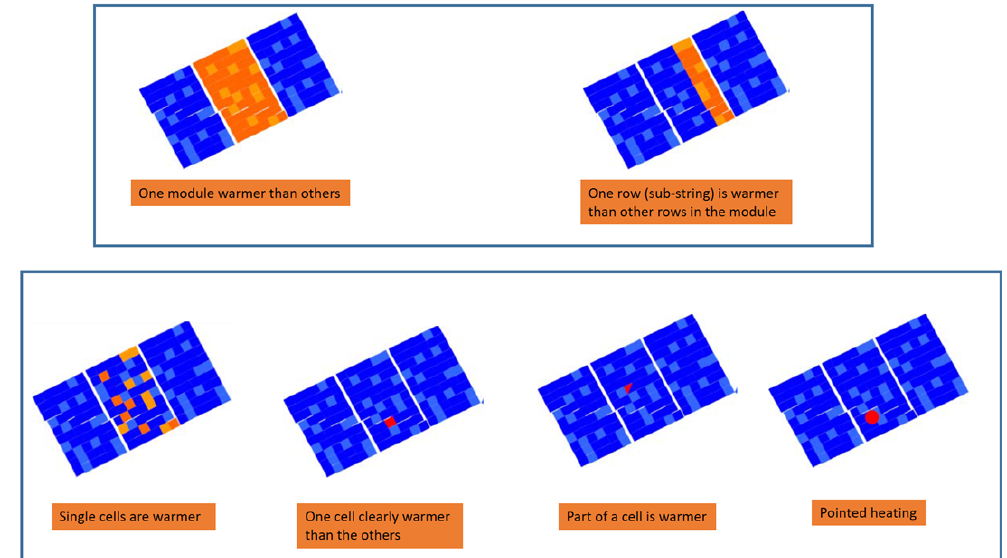
Figure 4. Summary of PV module IR image patterns observed in outdoor measurements (adapted from